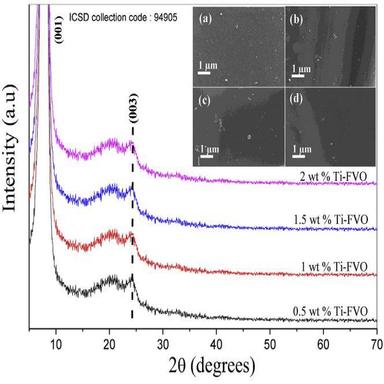
The comparative XRD patterns of the as deposited Ti-FVO thin films on the quartz substrates .